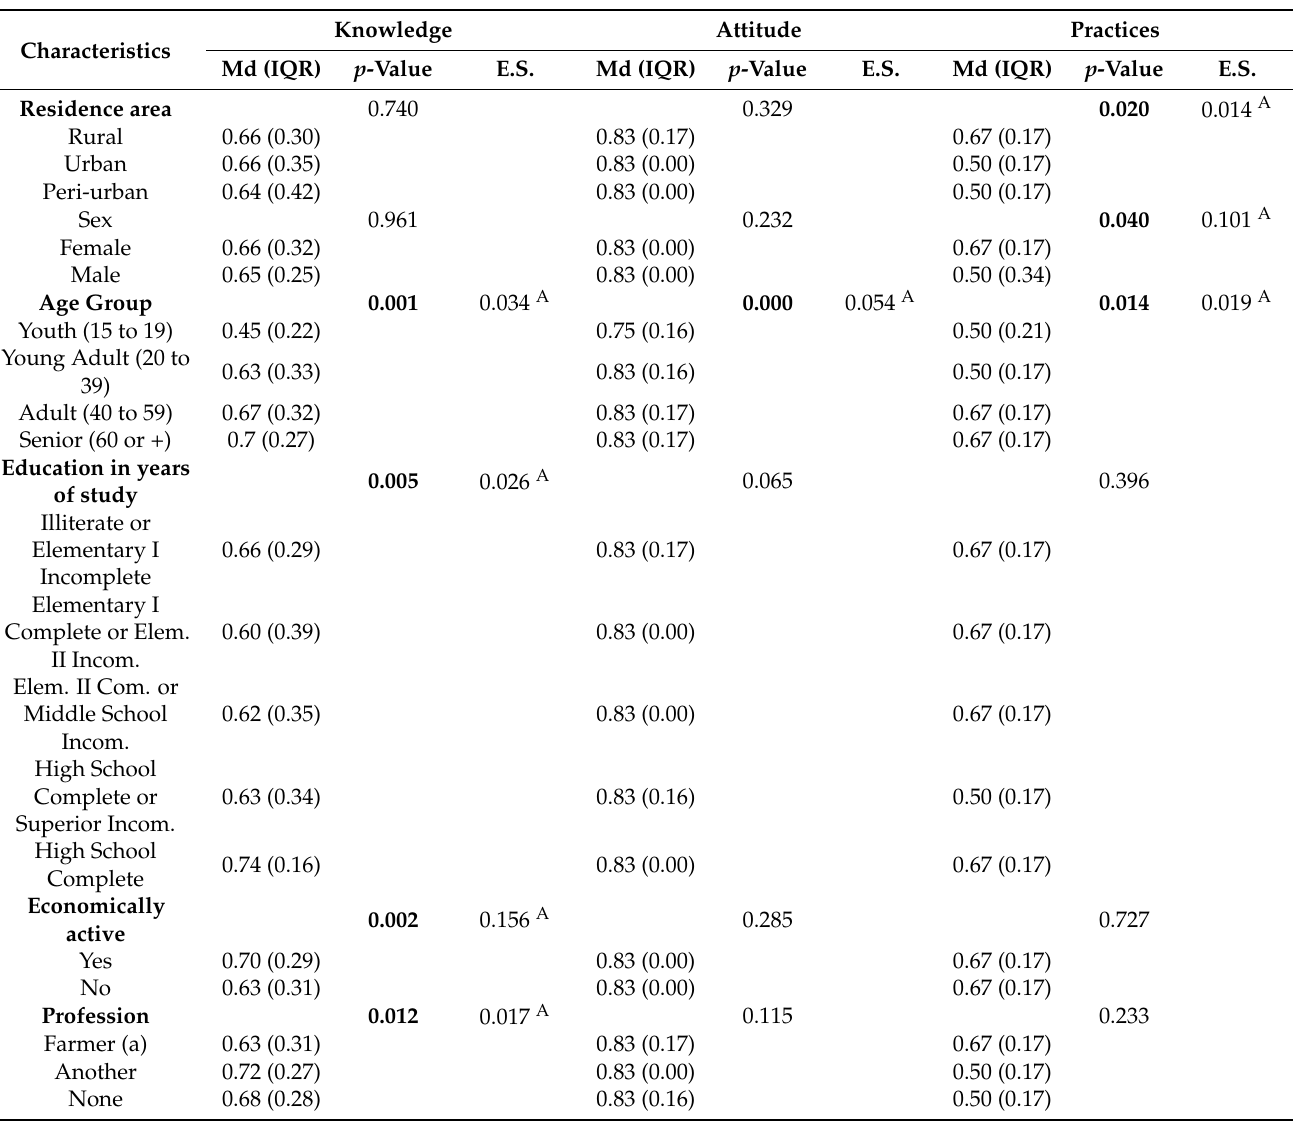
Table 3. Association of knowledge, attitude and practice scores with socio-demographic profile of residents from Feira Grande, Alagoas, Brazil, in